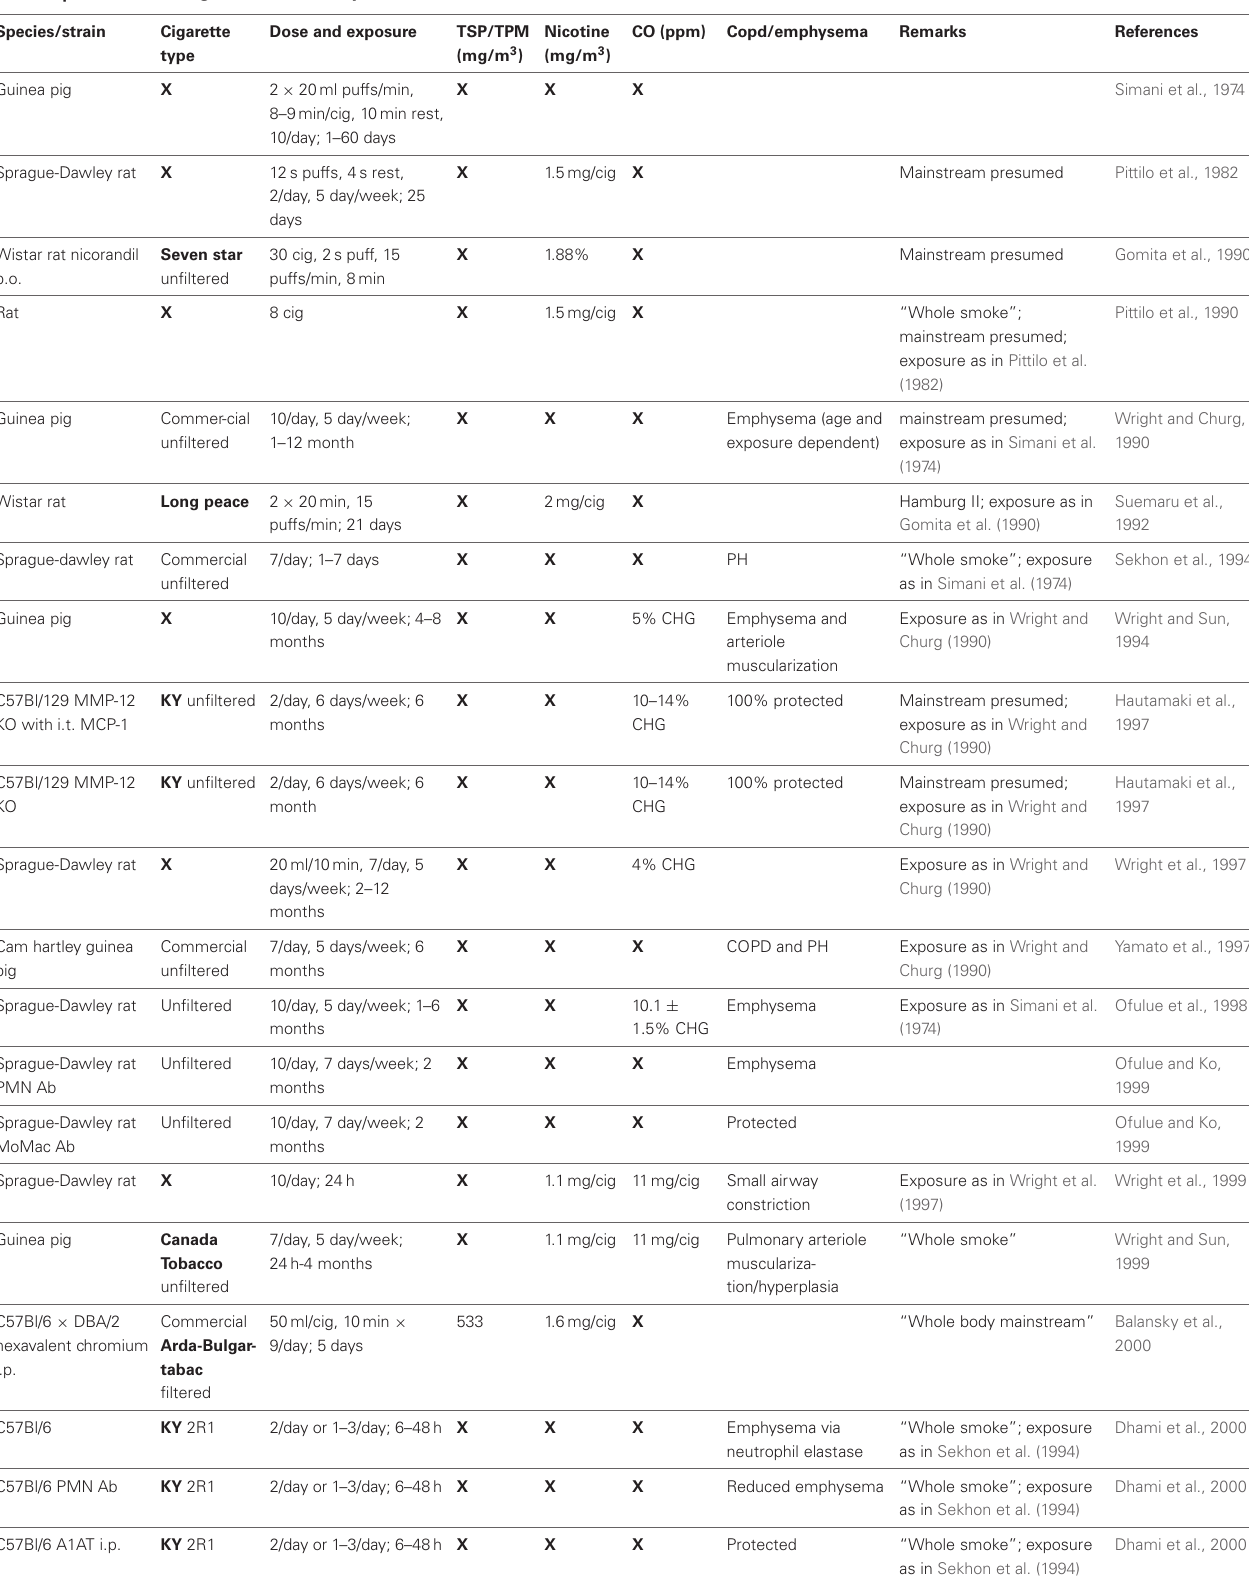
Table 1 | Mainstream cigarette smoke exposure modeled in